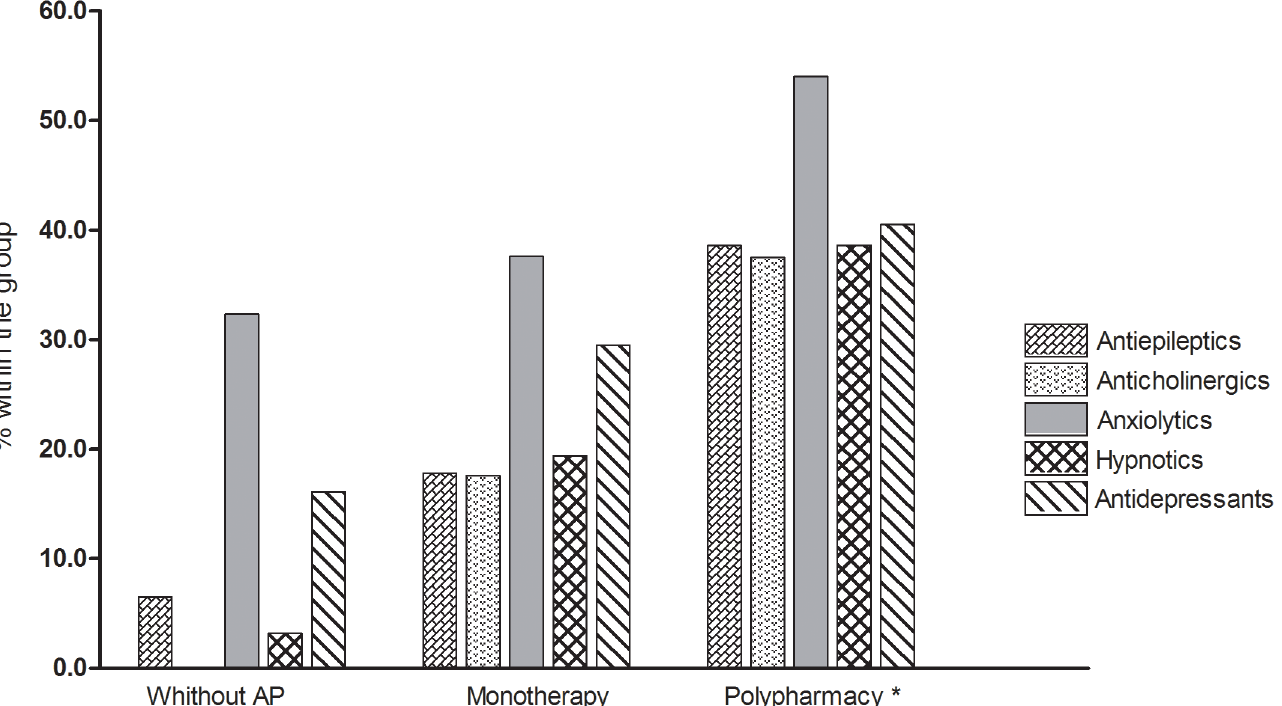
Fig 1. Comparison of the frequencies of psychiatric co-medications (other than antipsychotics) between the principal antipsychotic prescription patterns. An asterisk ( * ) indicates an observed frequency higher than expected in all χ 2 comparisons, p <